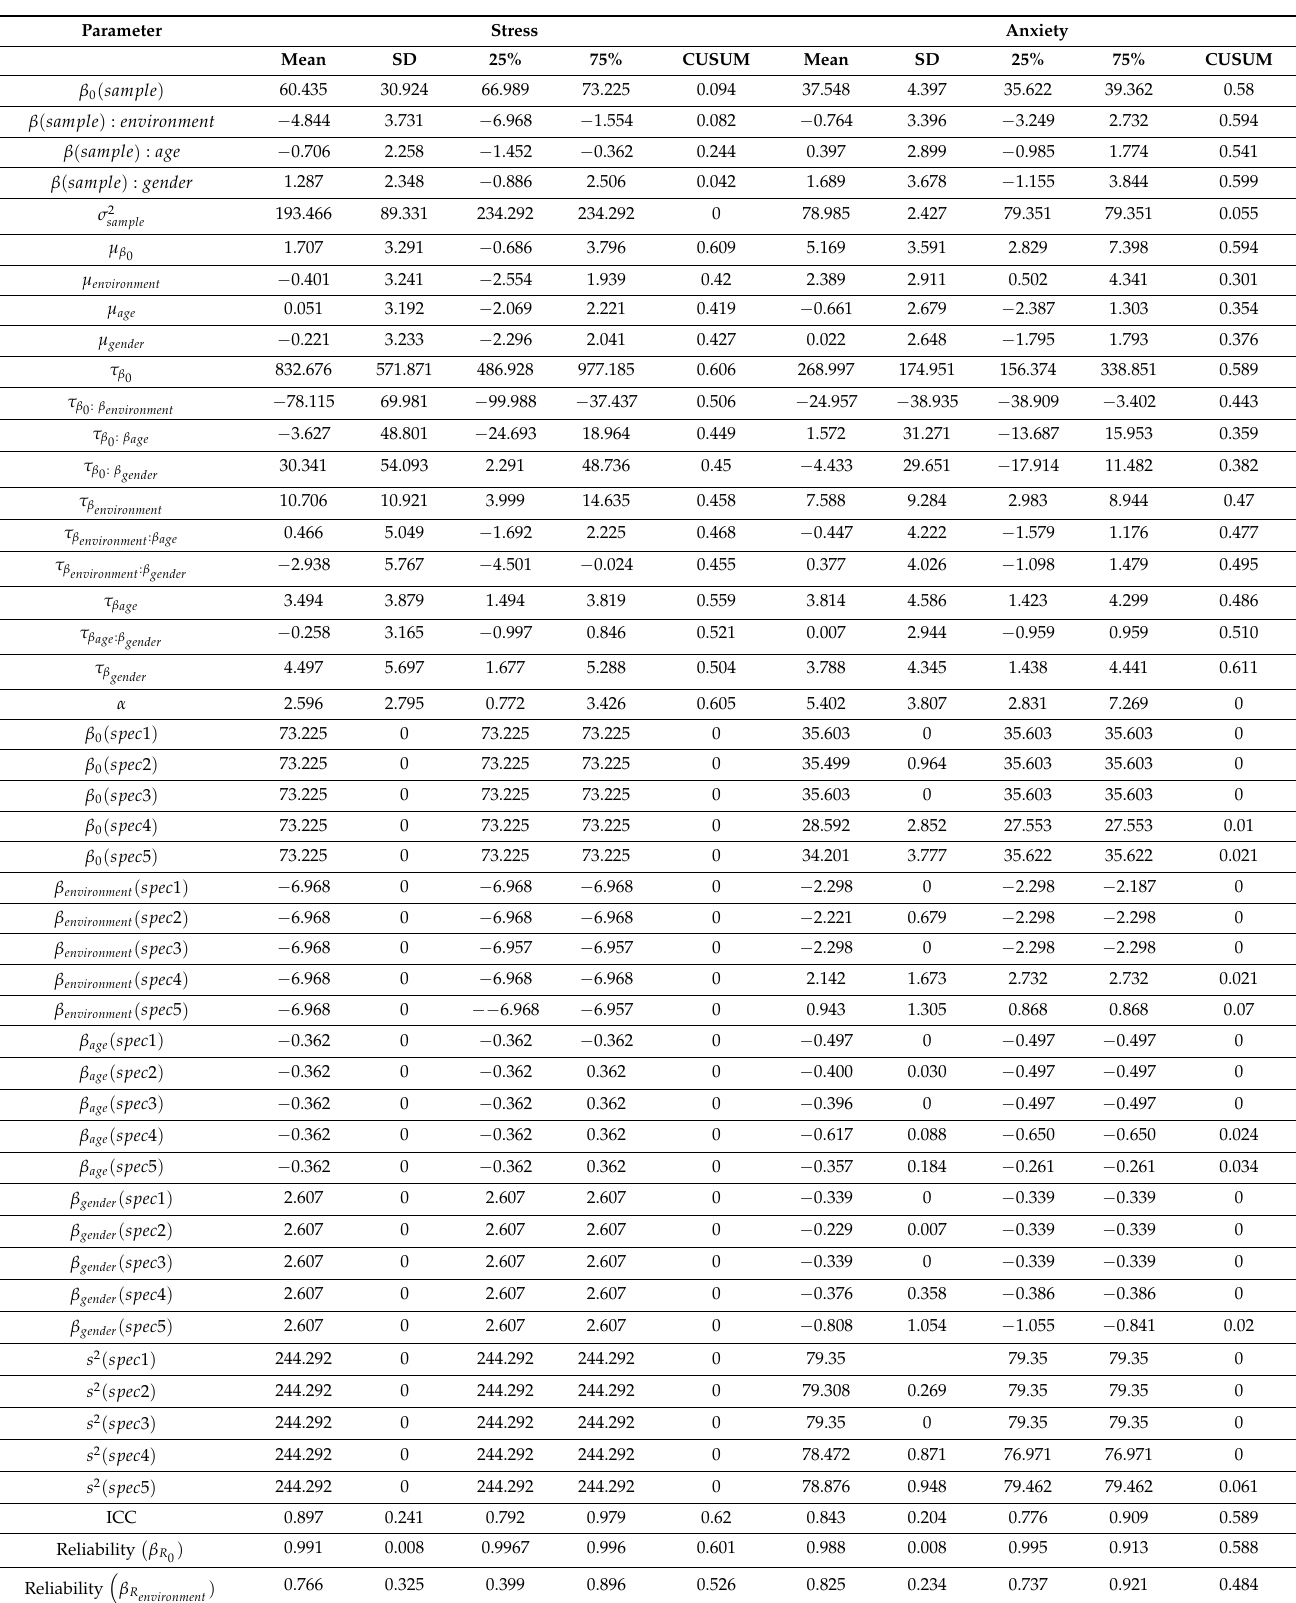
Table 4. The Posterior Summary Estimates for explaining students’ stress and anxiety scores according to the study